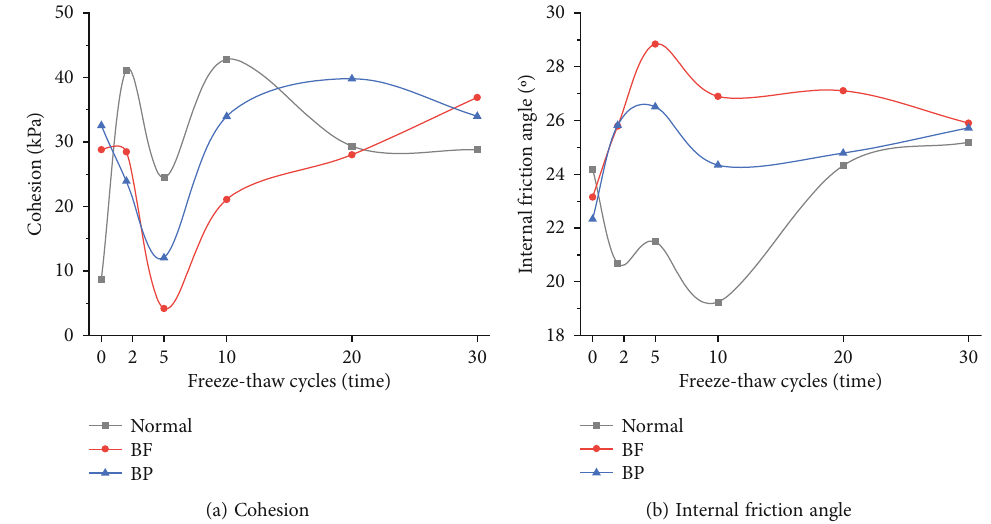
Figure 8: Destruction form.